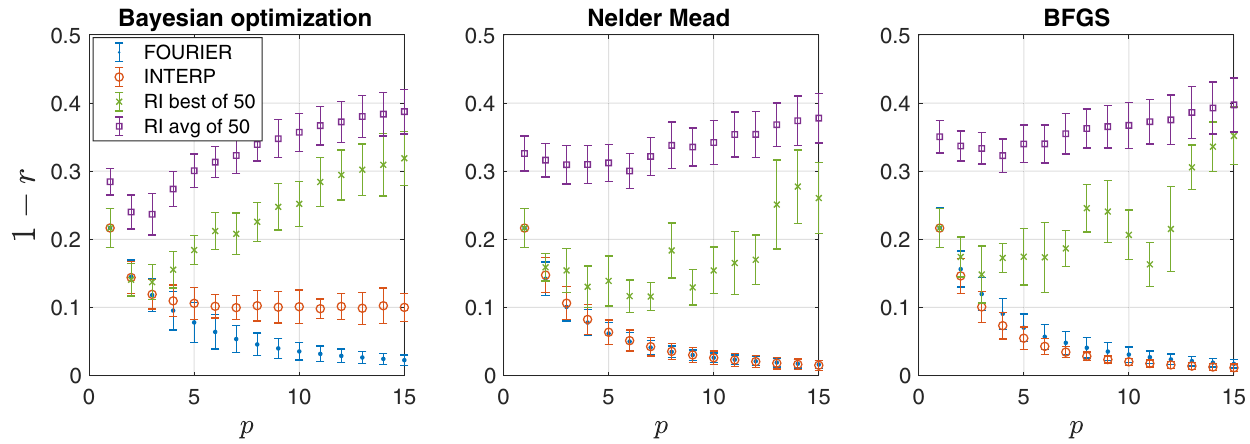
FIG. 14. Comparison of three different optimization routines applied to ten instances of 14-vertex w3R graphs. The initial point of optimization is generated with either our heuristics (FOURIER or INTERP) or random initialization (RI). We plot the fractional error 1 − r , averaged over instances, for each optimization routine and each initialization strategy at each p . The error bars are sample standard deviations from the ten instances. For our heuristic strategy, the optimization starts with a single initial point generated using our FOURIER[ ∞ ; 0 ] or INTERP heuristics as described in Appendix B. For the RI strategy, we generate 50 random initial points uniformly in the parameter space and optimize from each initial point; both the best and the average of 50 RI runs are